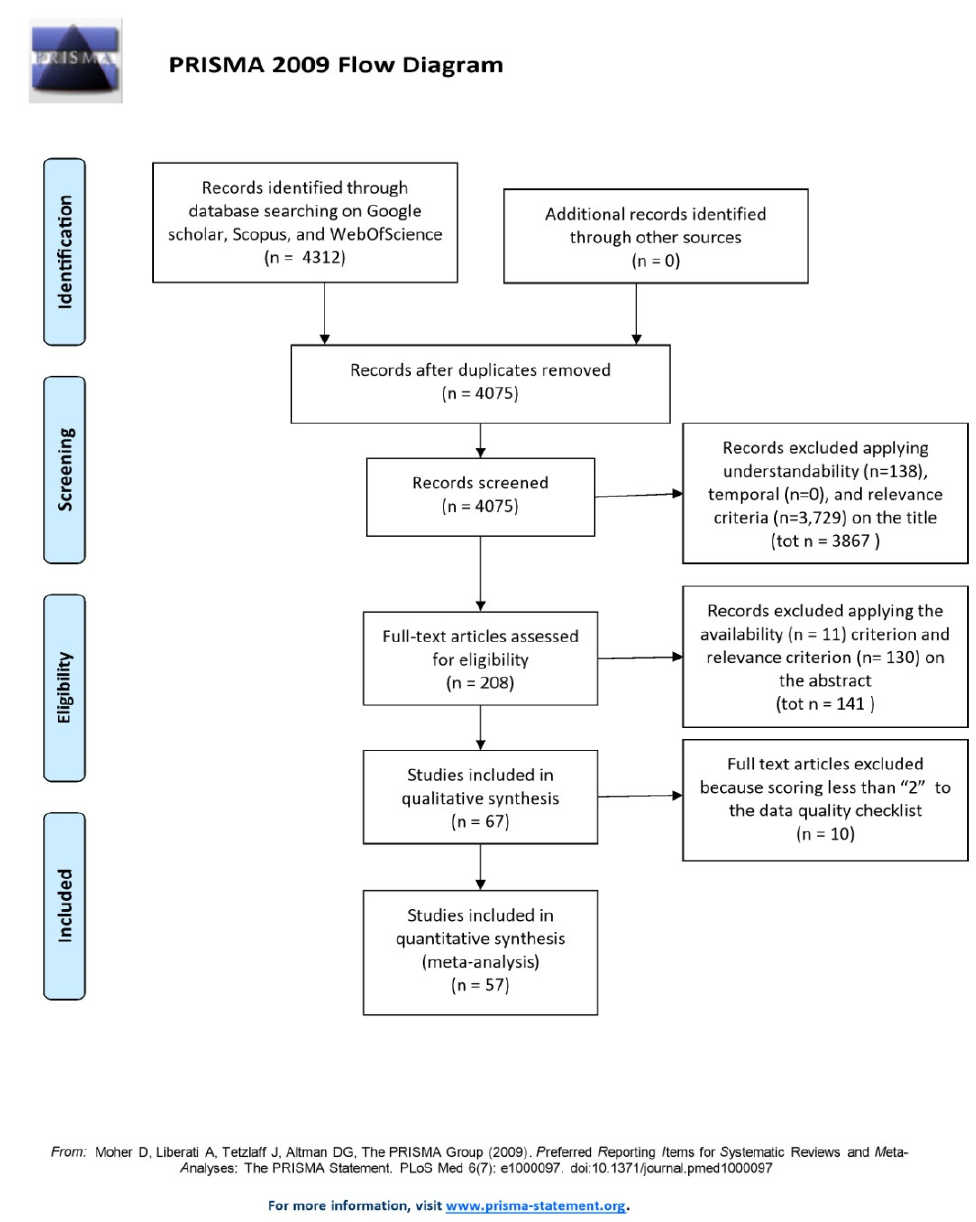
Figure 3. The PRISMA four-phase flow diagram. Adapted from [29].